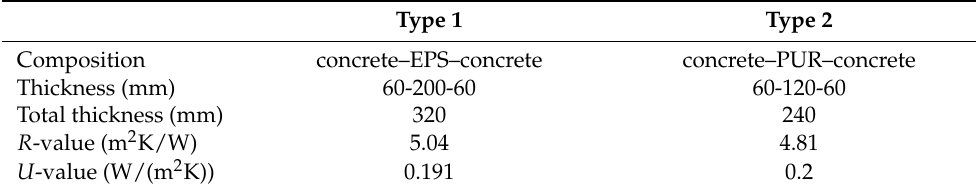
Table 2. Thermal properties of the wall’s